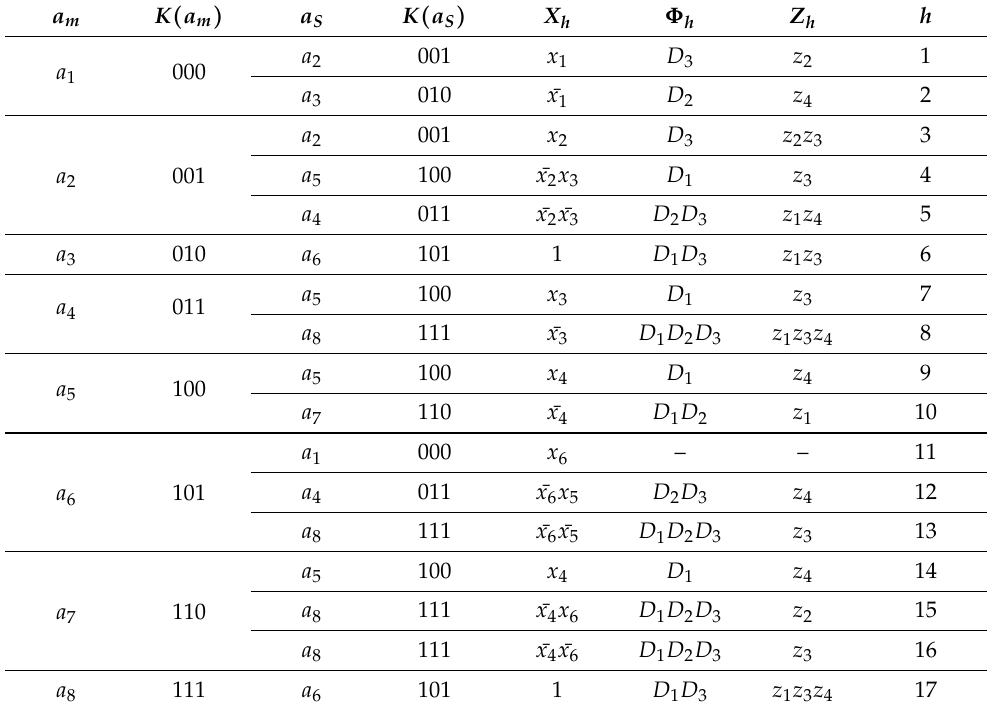
Table 2. Modified DST of Mealy FSM PZ ( S 1 ) . a